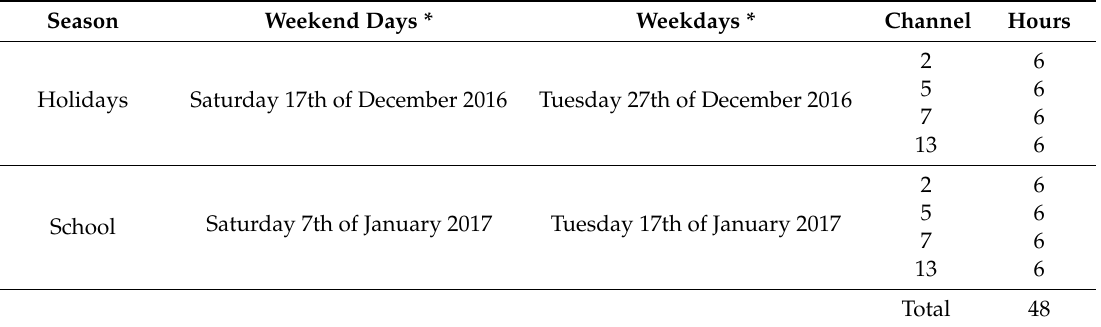
Table 1. Distribution of the analyzed